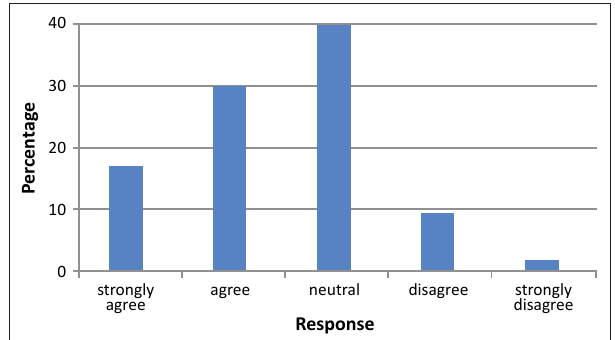
FIGURE 1 : ‘I love to read’.